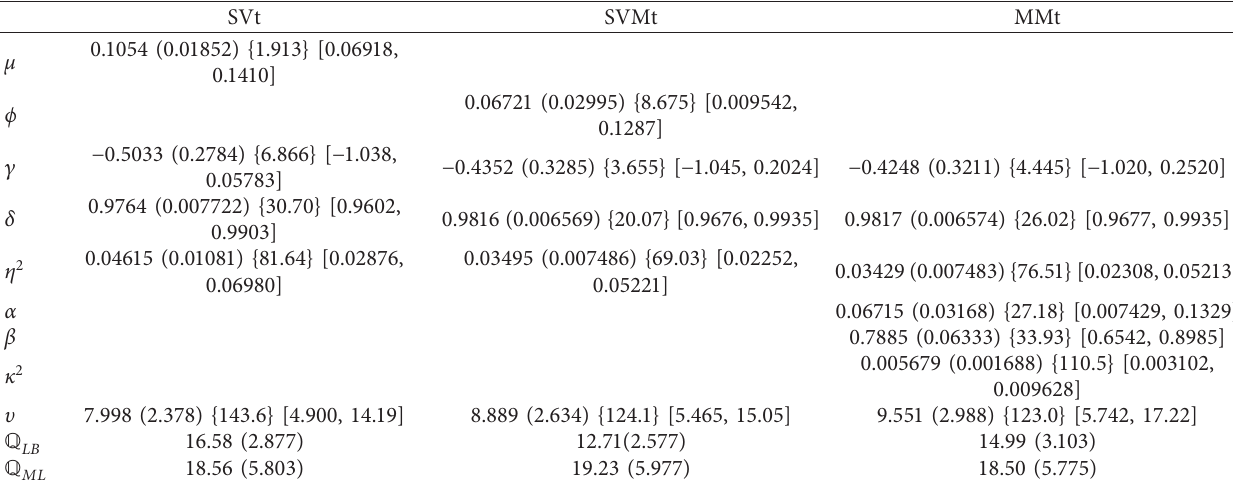
Table 7: Parameter posterior means, standard deviations (in parentheses), inefficiency factors (in braces), and 95% intervals (in square brackets) for the stochastic volatility models using the precision-based simulation smoother method.